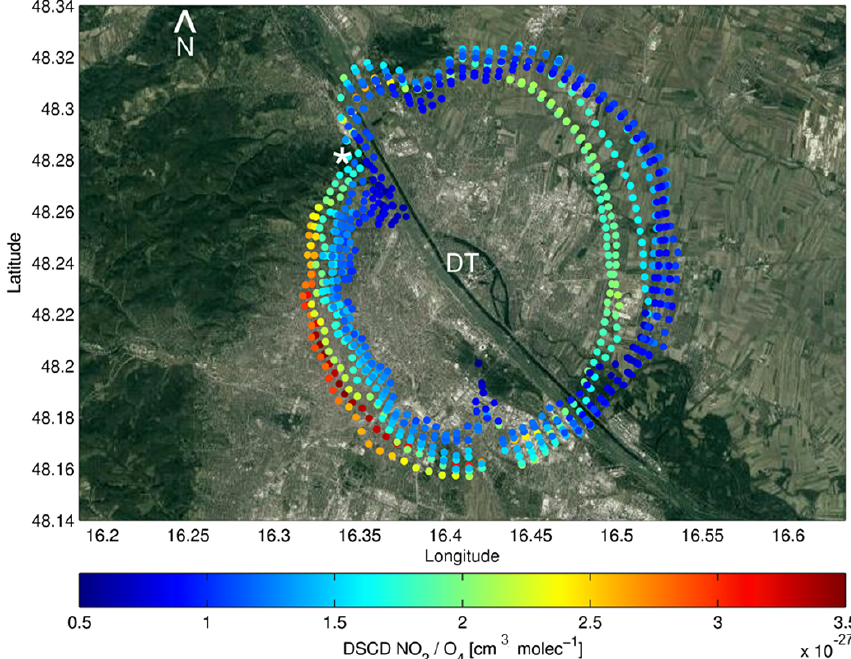
Figure 13. Spatial and temporal variability of the NO 2 / O 4 ratio (here, the radius is determined by DSCD O 4 values) on 10 May 2016 between 05:57 and 09:56UT observed by tower DOAS off-axis measurements. The position of the Vienna Danube Tower (DT) is highlighted in the center of the geographical map. The white asterisk represents the summit of Kahlenberg (484ma.s.l.), which is used for the estimation of horizontal optical path